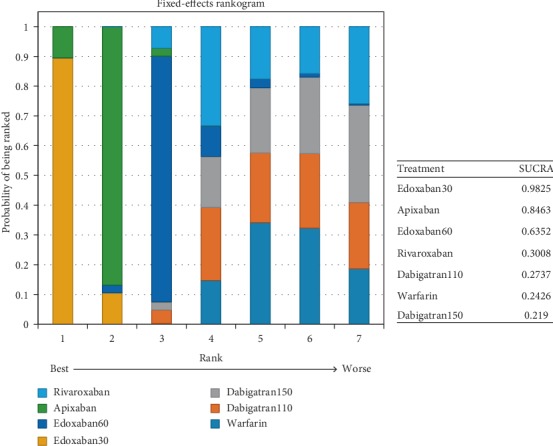
Ranking plots for the safety of the comparison among different treatments of patients with moderate renal function.